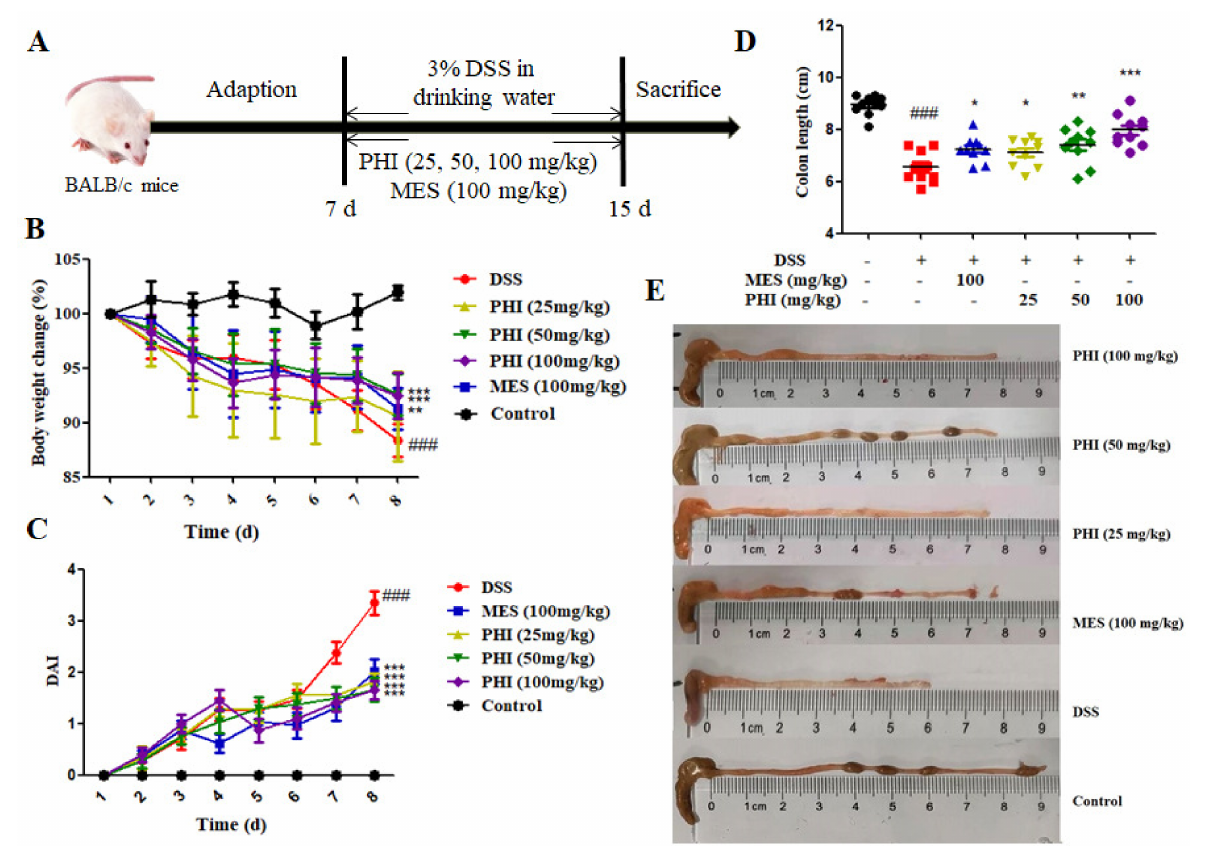
Figure 1. PHI alleviated the symptoms in DSS-induced colitis mice. ( A ) Experimental design. ( B ) Bodyweight changes from 1–8 d. ( C ) DAI scores from 1–8 d. ( D ) Colon lengths at 8 d. ( E ) Macroscopic pictures of colons. ### p < 0.001 vs. control group. * p < 0.05, ** p < 0.01, and *** p < 0.001 vs. DSS group. ( n = 10 mice per group).